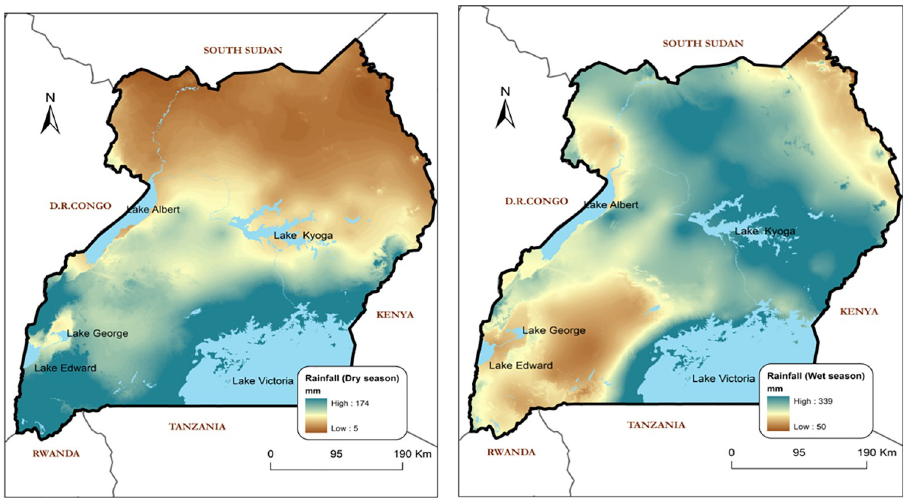
Fig 4. Precipitation Index as predictor variable for the model. This precipitation map was processed using ArcGIS 9.1 based on data from https://www.worldclim.org/data/worldclim21.html.